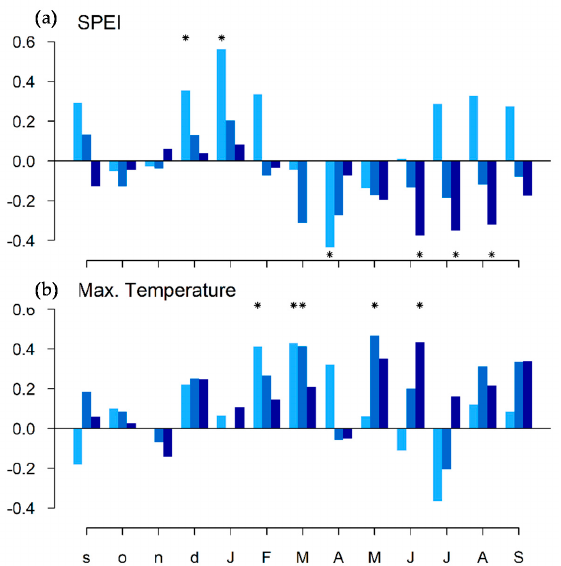
Figure 6. Relationship between Douglas fir wood density (detrended indices) and ( a ) monthly SPEI values and ( b ) mean maximum temperatures in the Beamaburu site. The relationships between minimum (MND, light blue bars), ring (RDG, medium blue bars) and maximum (MXD, dark blue bars) wood density are shown for September in the previous year (months abbreviated by lowercase letters) to September in the year of tree-ring formation (months abbreviated by uppercase letters). Significant relationships ( p < 0.05) are shown with asterisks (*) for each variable.